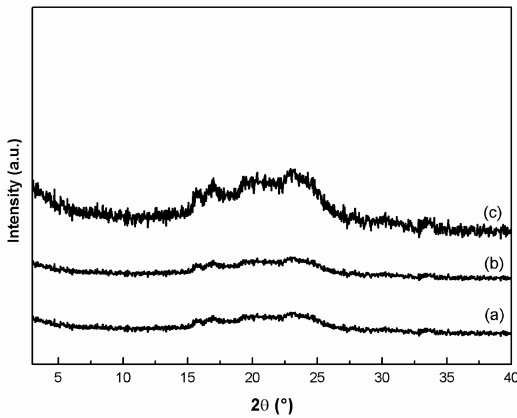
Figure 5. XRD of the composite samples: ( a ) PBT/PEOT ZrP-GTM 5 wt %; ( b ) PBT/PEOT ZrP-GTM 10 wt %; ( c ) PBT/PEOT ZrP-GTM 20 wt